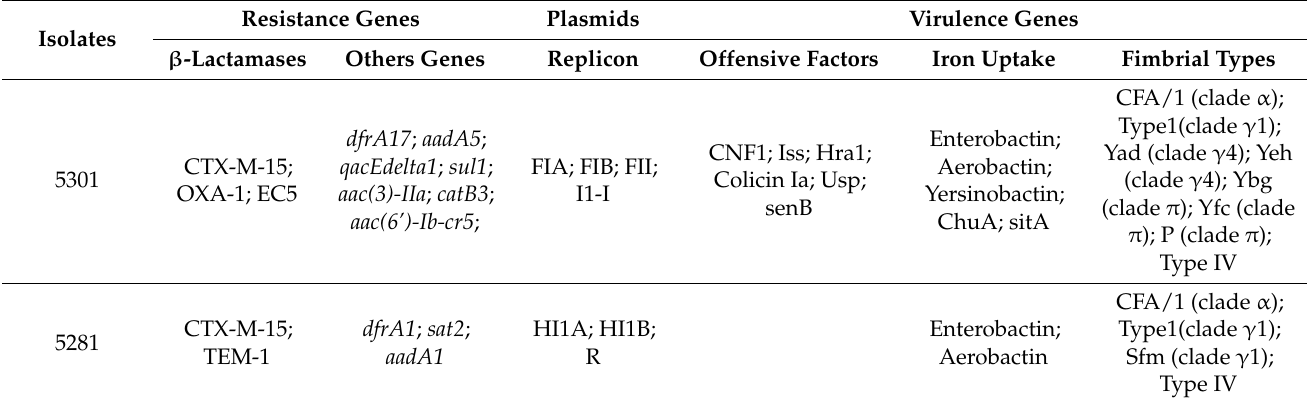
Table 3. Genetic features of E. coli 5301 pathogenic isolate (B2) compared with E. coli 5281 commensal isolate (A), from effluent (BEI-EFL10TM2) and influent (FNw-AFB7GM)